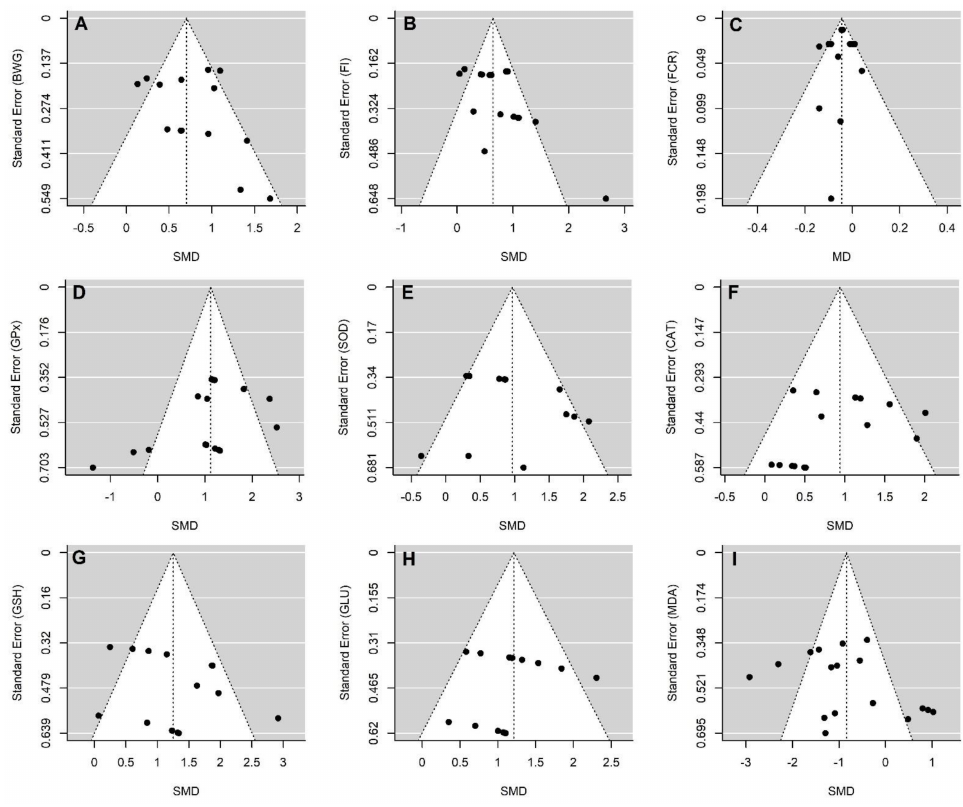
Figure 4. Standard error of funnel plots for the body weight gain ( A ), feed intake ( B ), feed